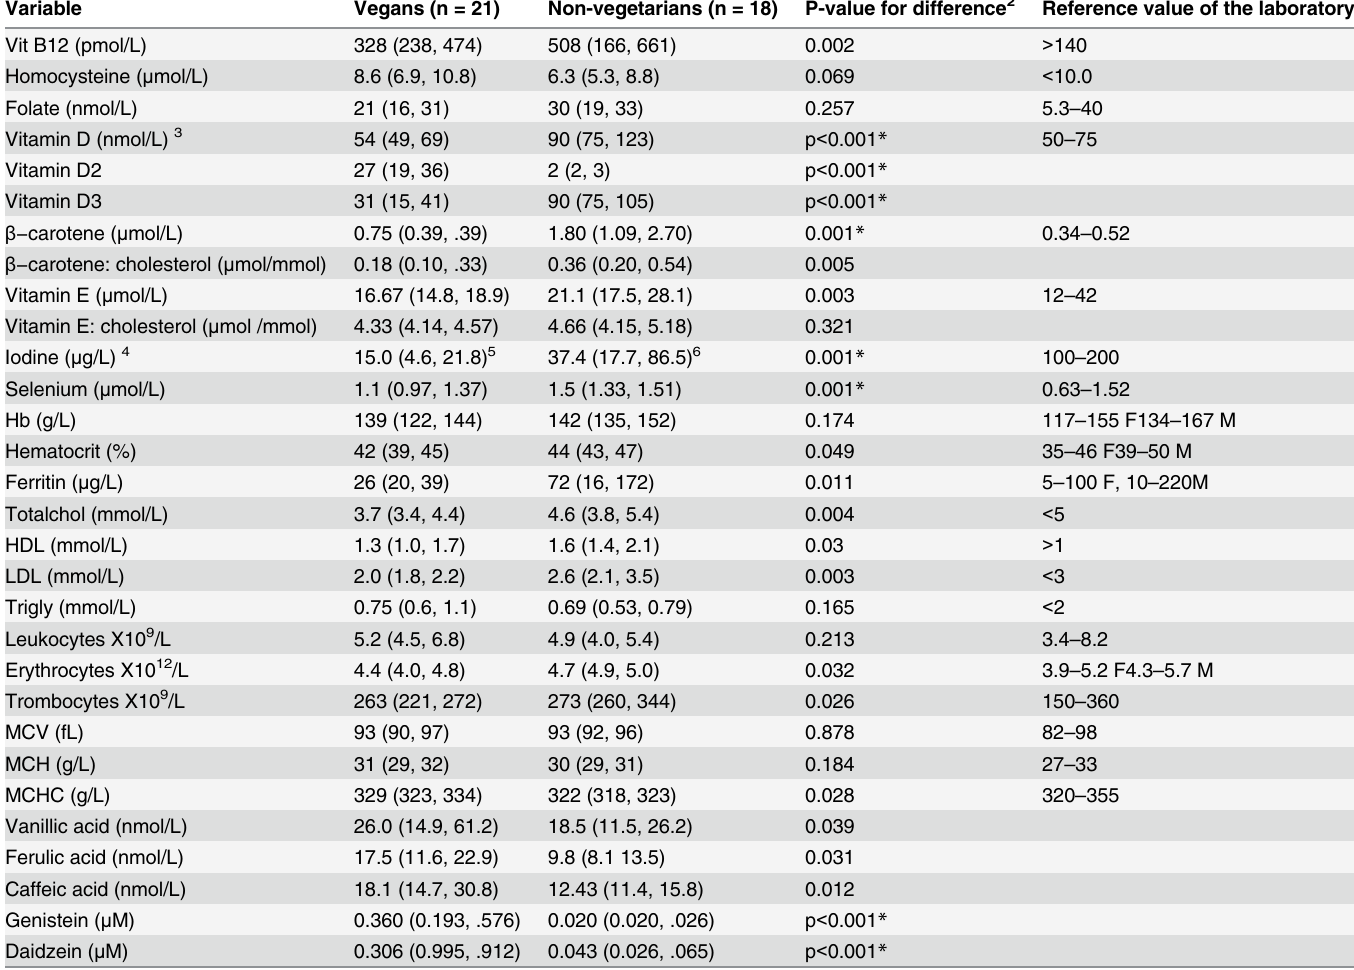
Table 4. Serum concentrations of nutrients, non-nutrients, and basic clinical data of vegans and non-vegetarians 1 .